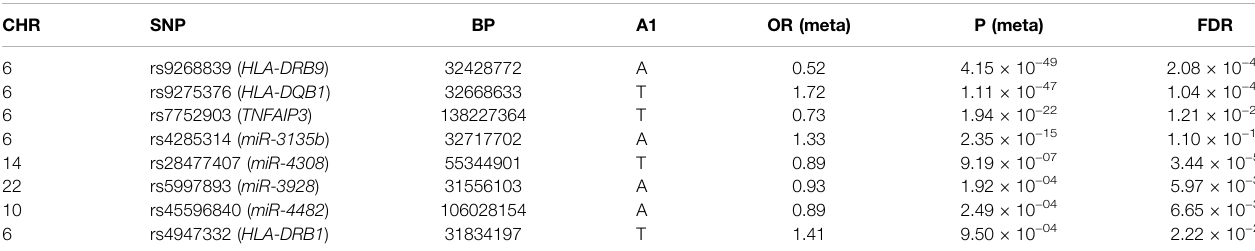
TABLE 3 | Meta-analysis between our study and previous East-Asian population-based RA GWAS